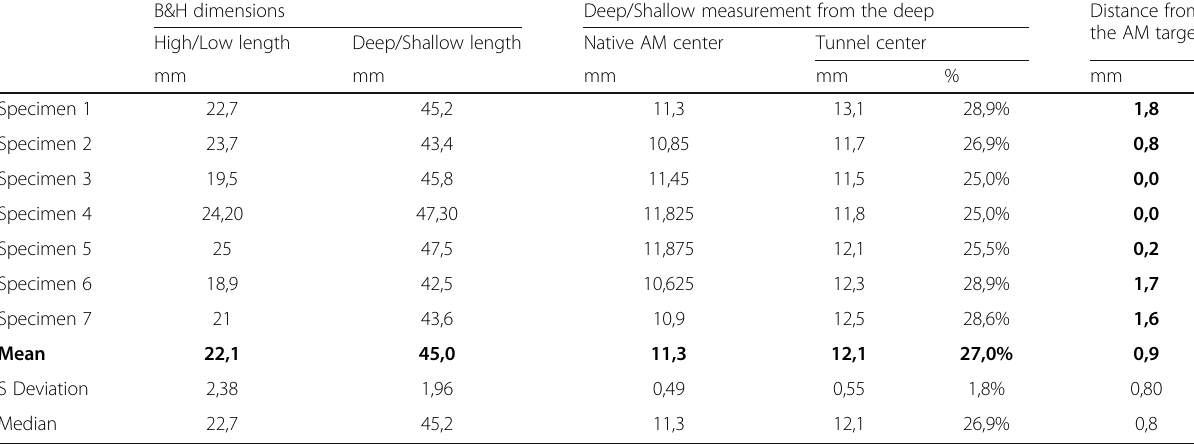
Table 1 Results for the seven specimens with two analyses: The distance of the tunnel center from the Bernard & Hertel (B&H) deep quarter line according to the quadrant